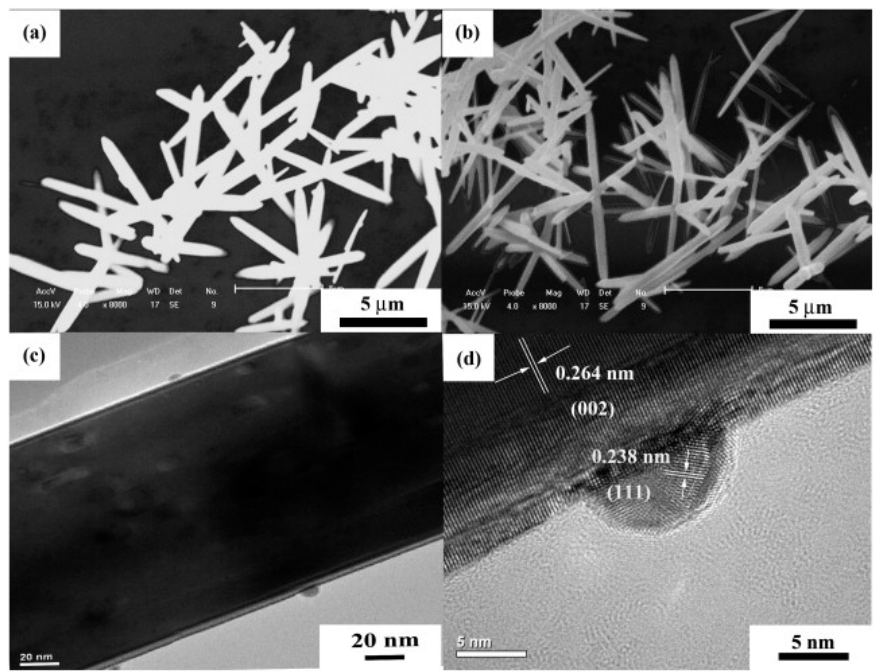
Figure 58. SEM images of ( a ) pure ZnO nanorods and ( b ) Ag-ZnO nanorods-3; ( c ) TEM image and ( d ) High-resolution transmission electron microscopy (HRTEM) image of Ag-ZnO nanorods-3. Reproduced with permission from [86].